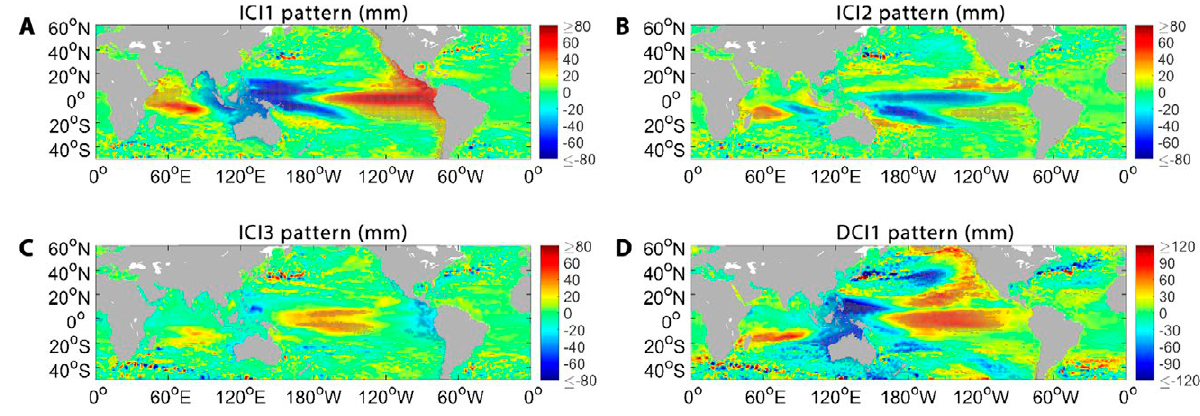
Fig. 5. – Patterns of ICIs and DCIs derived from the corresponding coefficients in MVLR: A, ICI1; B, ICI2; C, ICI3; and D, DCI1 for the same dataset. Stippling indicates a trend exceeding the 95% confidence